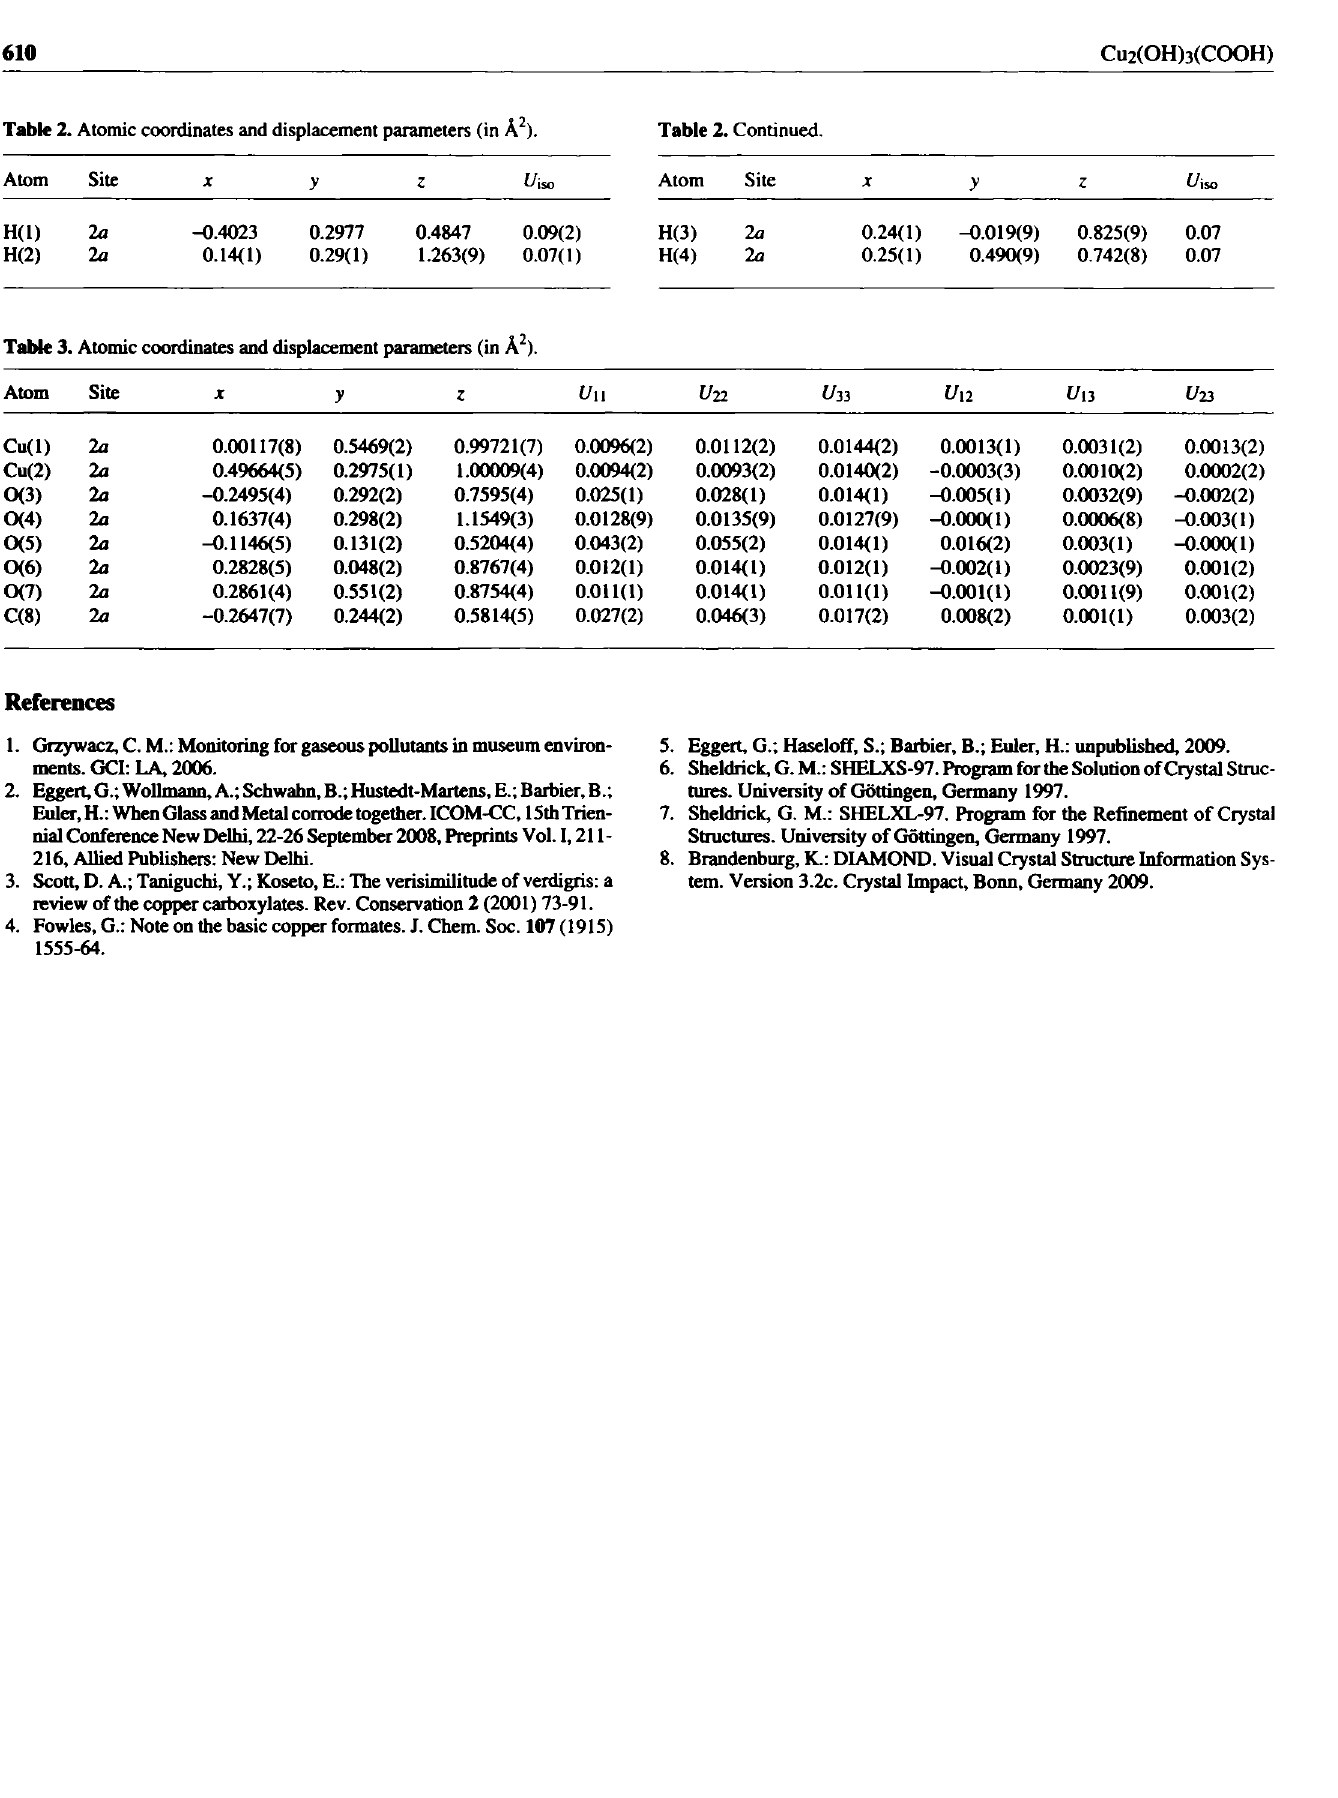
Table 2. Atomic coordinates and displacement parameters (in À 2 ). Table 2. Continued.